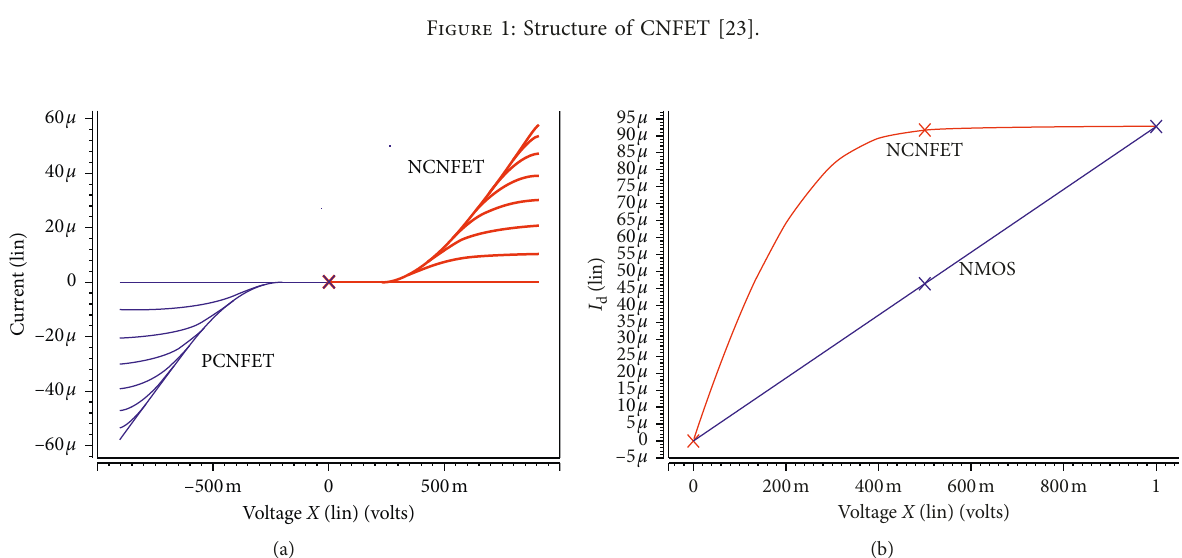
d - V ds of NCNFET and PCNFET for various values of V gs . (b) I d - V ds of